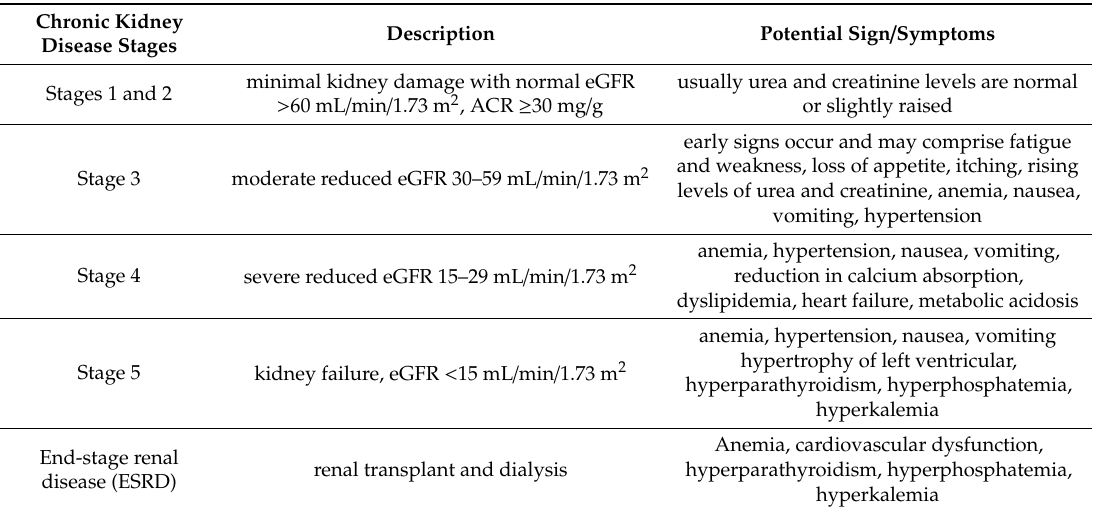
Table 1. Chronic kidney disease staging definitions and correspondence with Kidney Disease Outcomes Quality Initiative (KDOQI) Clinical Practice Guidelines categories.